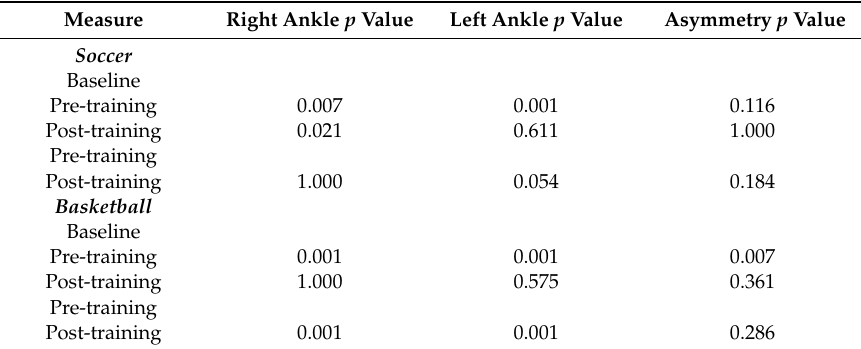
Table 3. Bonferroni correction values for the intra-subject (time) e ff ects.